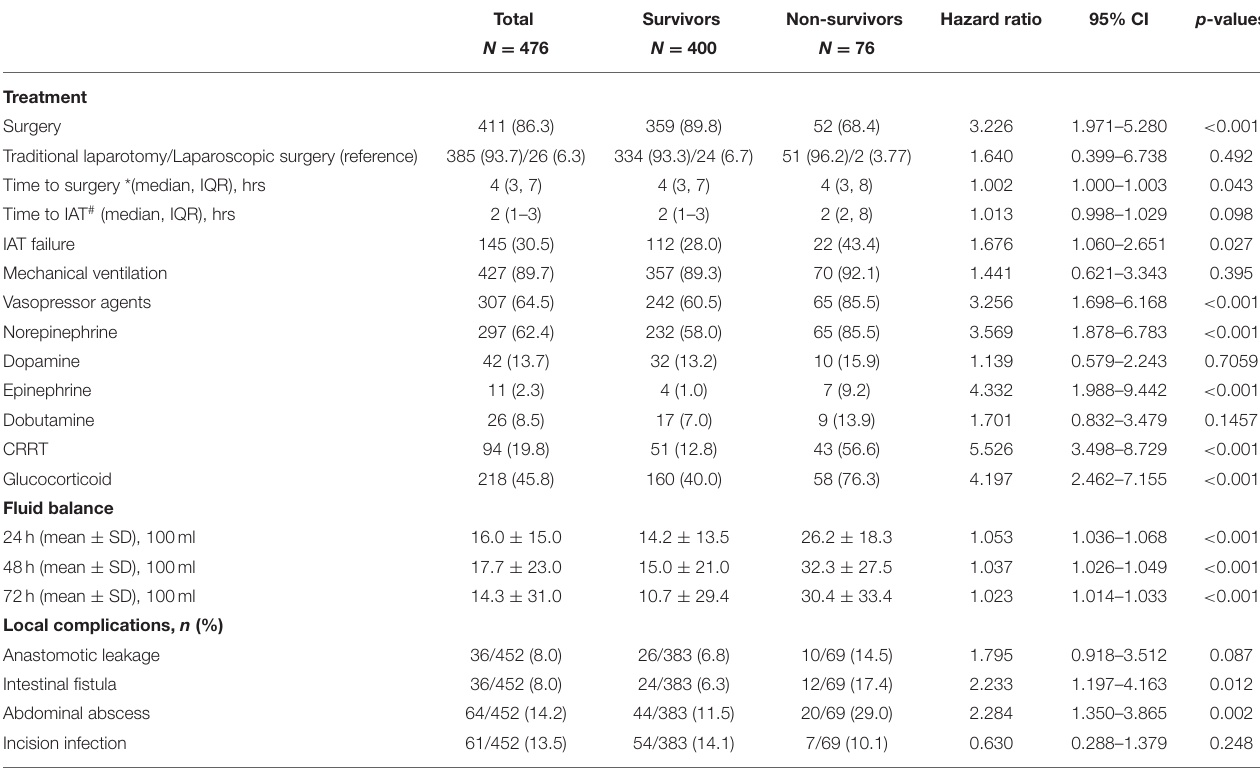
TABLE 3 | Antibiotic, source control, and complications of IAIs patients in ICU.